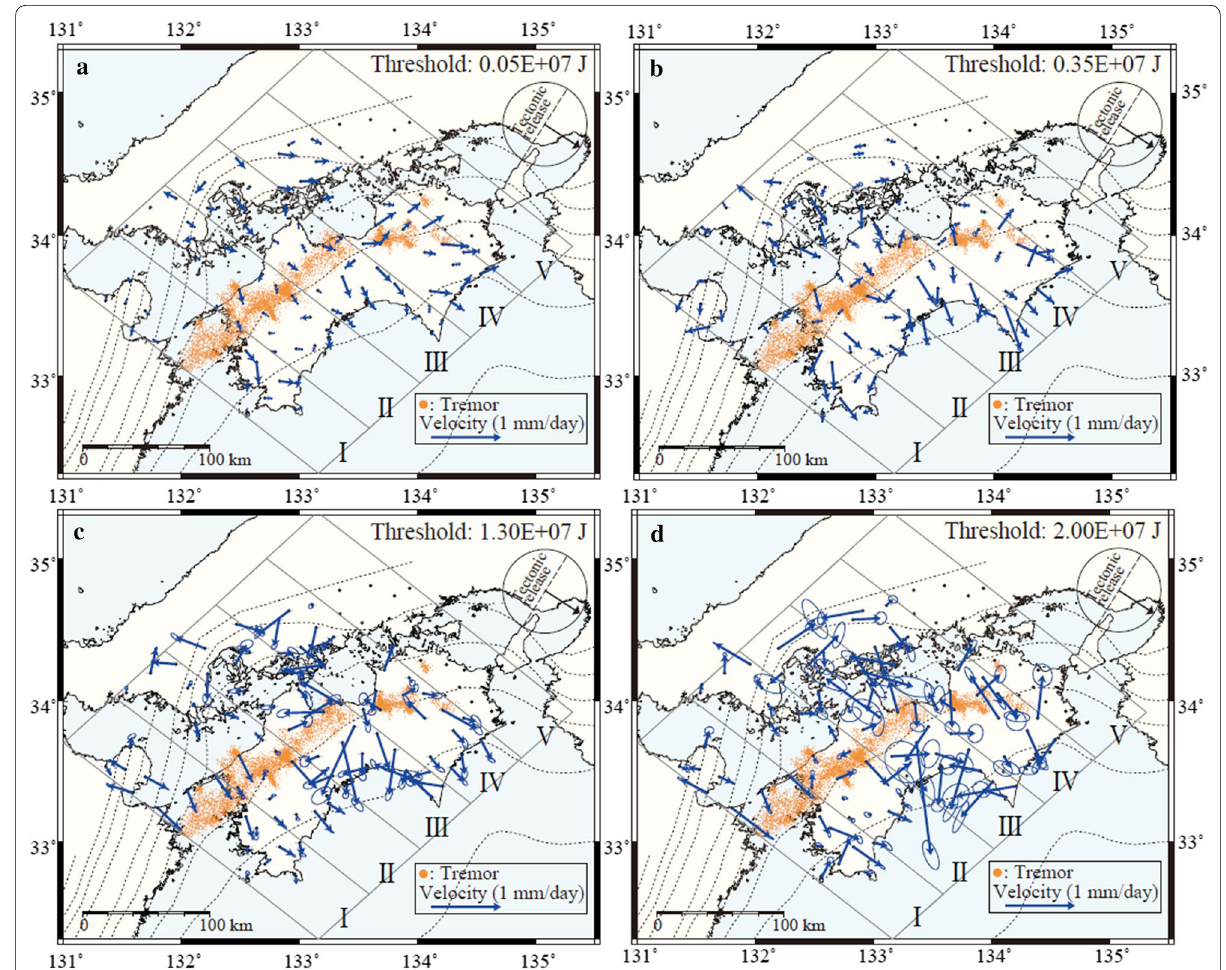
Fig. 3 Examples of the release velocity patterns with various thresholds between April 1, 2004 and December 31, 2009. Blue arrows indicate the estimated release velocities per day. Error ellipses at arrow heads show one standard error. Orange dots indicate the epicenters of non-volcanic tremors (Annoura et al. 2016) during our analysis period. Black arrows in circles are the expected directions of tectonic stress release, which is opposite to the direction of the subducting Philippine Sea Plate based on MORVEL (DeMets et al. 2010). a Release velocities with a tremor energy threshold of 0.05 × 10 7 J . b Same as a , but with a tremor energy threshold of 0.35 × 10 7 J . c Same as a , but with a tremor energy threshold of 1.30 × 10 7 J . d Same as a , but with a tremor energy threshold of 2.00 × 10 7